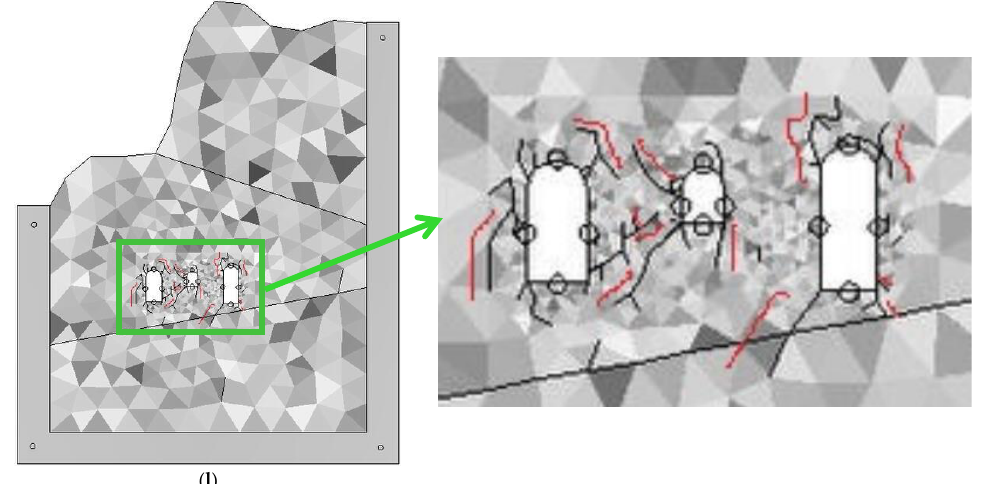
Figure 5. Failure process of SR of underground cavern group during excavation in Scheme 1: ( a ) The excavation began; ( b ) the 1st step of excavation is completed; ( c ) the 2nd step of excavation is completed; ( d ) the 3rd step of excavation is completed; ( e ) the 4th step of excavation is completed; ( f ) the 5th step of excavation is completed; ( g ) the 6th step of excavation is completed; ( h ) the 7th step of excavation is completed; ( i ) the 8th step of excavation is completed; ( j ) the 9th step of exca- vation is completed; ( k ) the 10th step of excavation is completed; ( l ) the 11th step of excavation is completed.